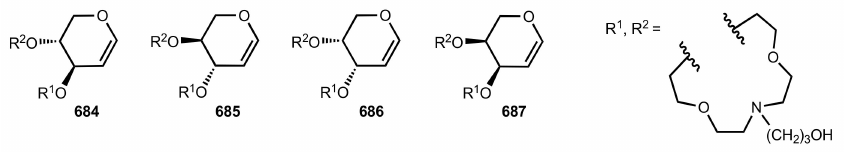
Figure 45. Glycal-based aza-crown ethers prepared by Bak ó and co-workers. The two enantiomeric pairs of lariat ethers were tested as phase transfer catalysts in liquid–liquid and solid–liquid systems for epoxidation, Michael or Darzens reactions [283] (Scheme 177). The epoxidation reaction of the chalcone 602 carried out with tert -butylhydro peroxide in a liquid–liquid two phases system gave exclusively the trans -epoxyketone 609 . Using the D -xylal-based catalyst 684 , the (2 S ,3 R )-configured epoxyketone was obtained (77% ee ), whereas the L -xylal-based macrocycle afforded the (2 R ,3 S ) enantiomer (72% ee ). The D - or L -arabinal-based crown ethers 686 or 687 gave poor enantioselectivities ( ee = 8 and 7%); however, in this case as well, the selectivity was reversed. The same trend was observed for the Michael reaction between diethyl acetamidoma- lonate and β -nitrostyrene 604, which took place with modest enantiomeric excesses. On the other hand, in the Darzens reaction involving α -chloroketones 688 and benzaldehyde, enan- tiomeric excesses of 85 (2 S ,3 R ) and 91% (2 R ,3 S ) were observed for the trans -epoxyketones 689 obtained from the phenyl-substituted 2-chloroindanone 688 (R = Ph) using the D - or L -xylal-based catalyst 684 or 685 , respectively. Even if some enantiomeric excesses were modest, this work is interesting because it demonstrated that the configuration of the sugar unit annulated to the crown ether determined the stereochemical preference of the